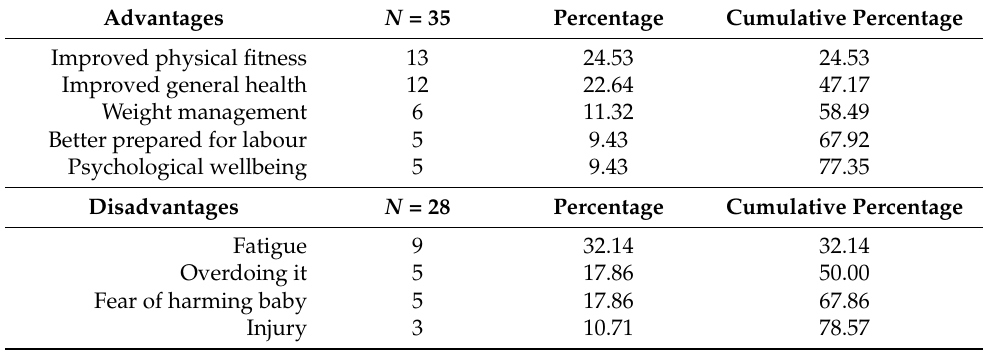
Table 1. Modal salient behavioural beliefs of pregnant women in East Kent.